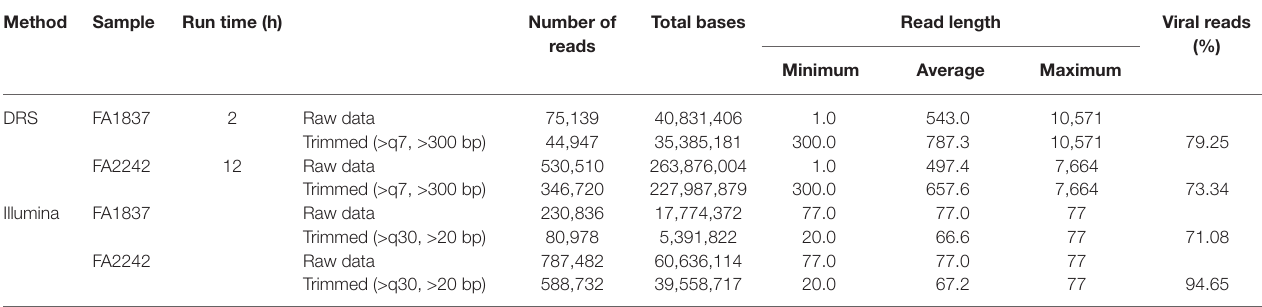
TABLE 1 | Sequencing statistics of DRS and Illumina HiSeq.